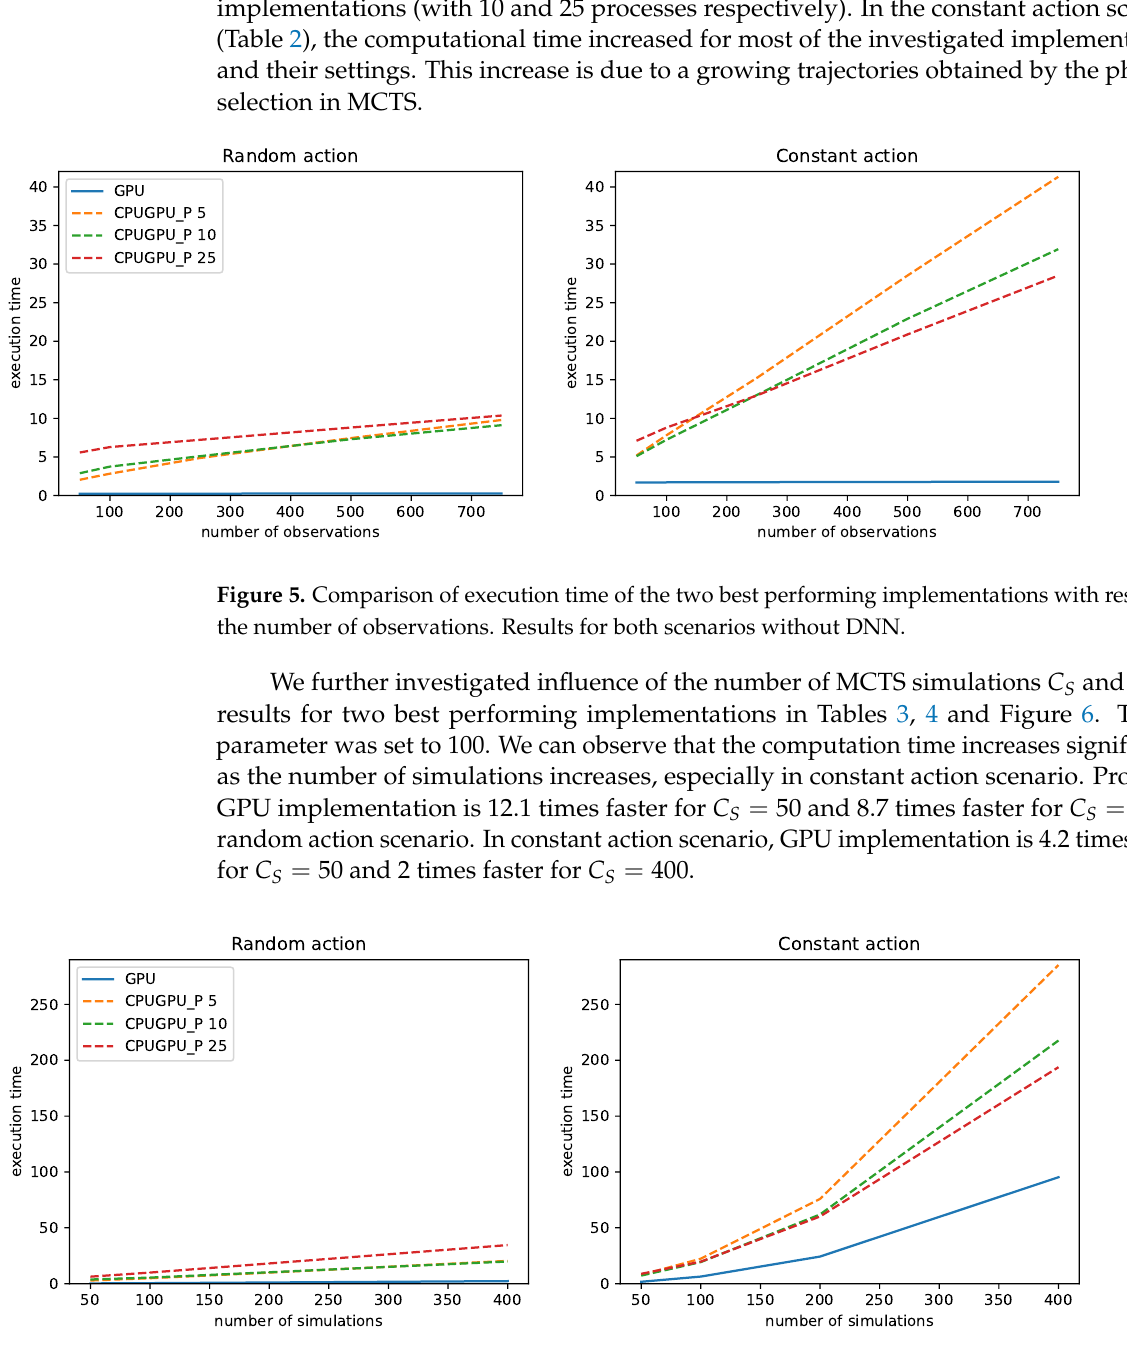
Figure 6. Comparison of execution time of the two best performing implementations with respect to the number of simulations. Results for both scenarios without